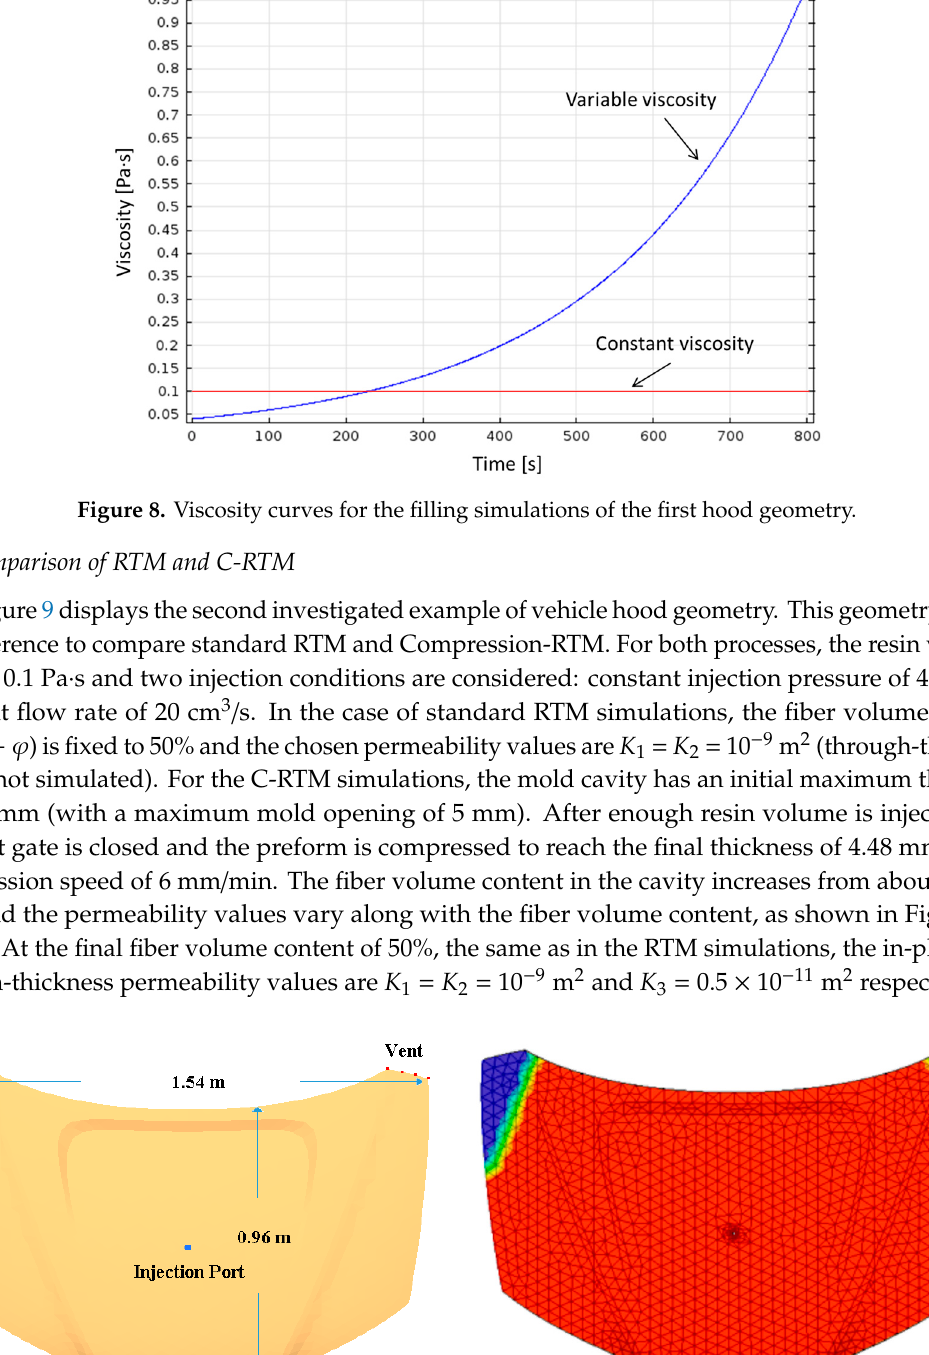
Table 5. Fill times and injectability numbers for filling cases of the first hood geometry.